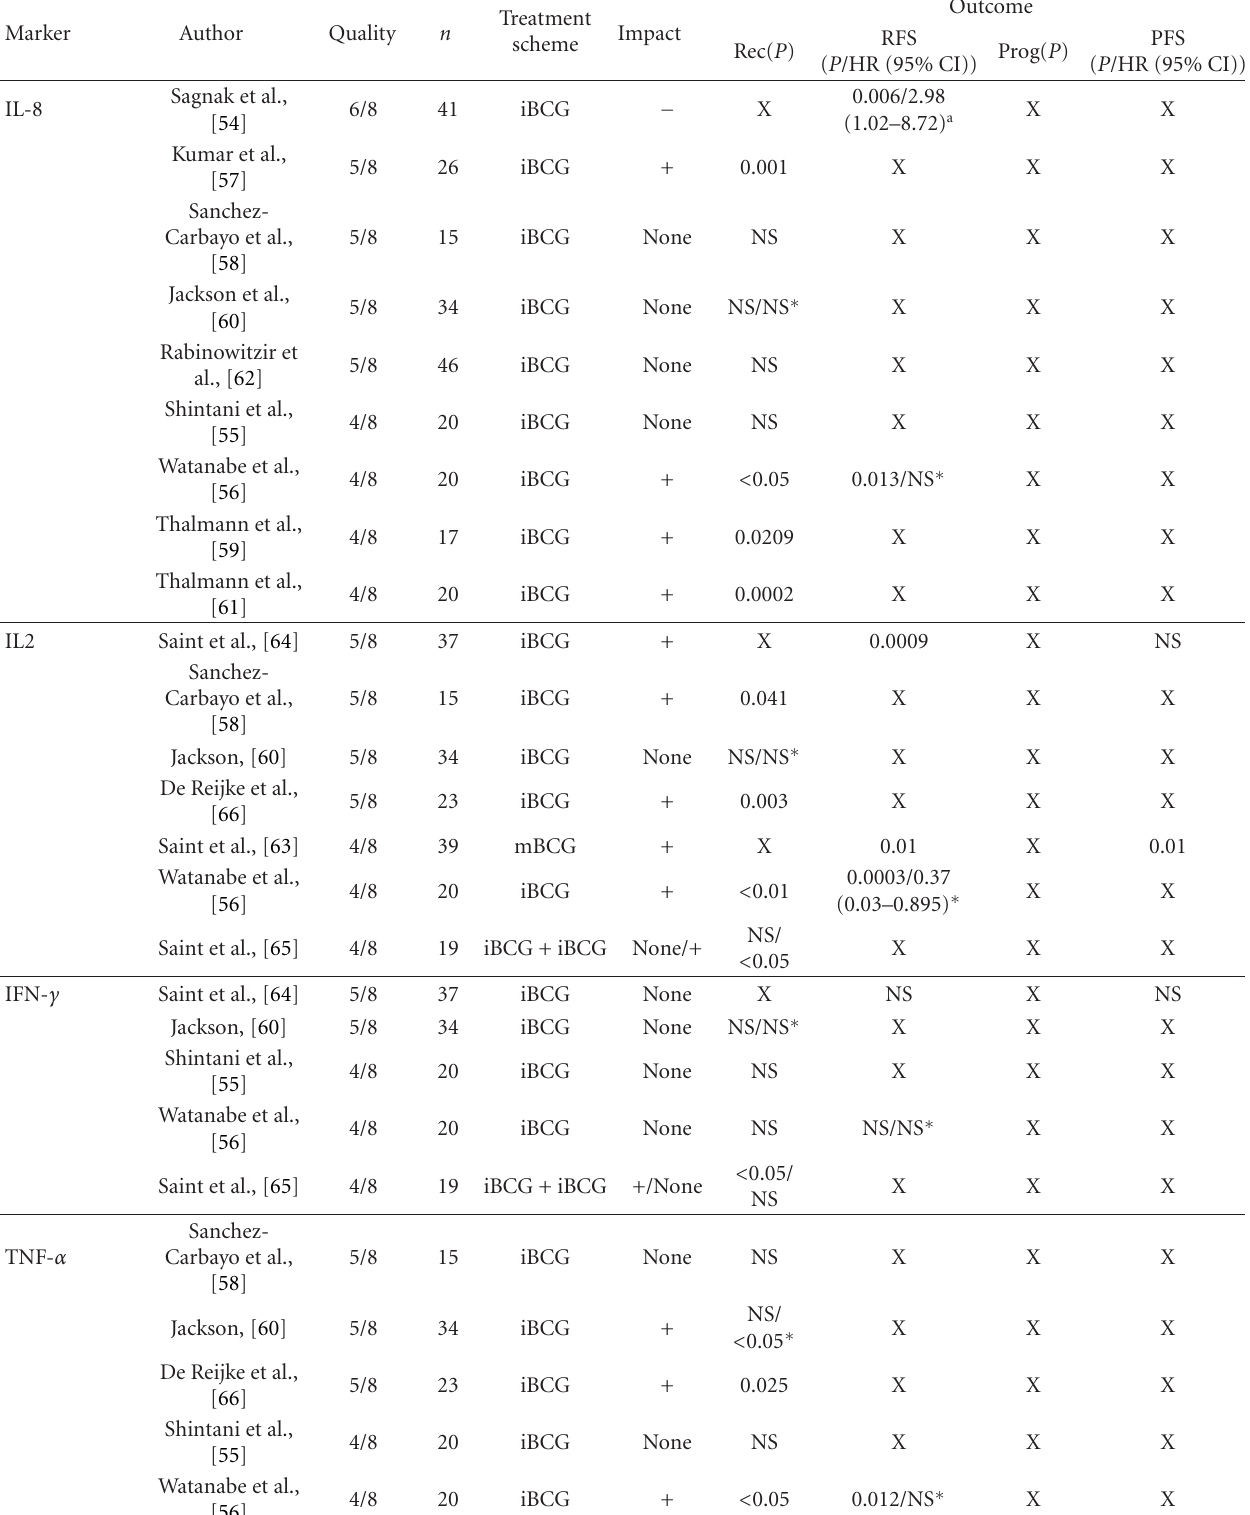
Table 2: Urinary markers predicting BCG treatment outcome. The markers are ordered from the most studied to the less, and, within each marker, the studies are ordered by quality